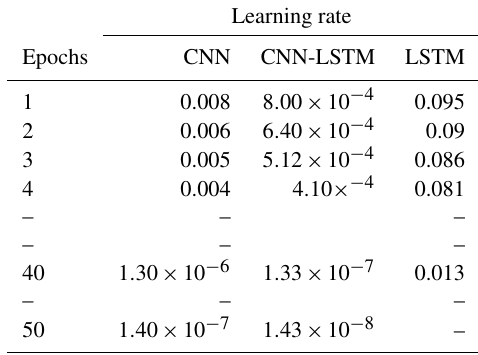
Table 4. The adaptive learning rate for 50 epochs. Table 5. The number of jam and no-jam events used in the rain and validation and test